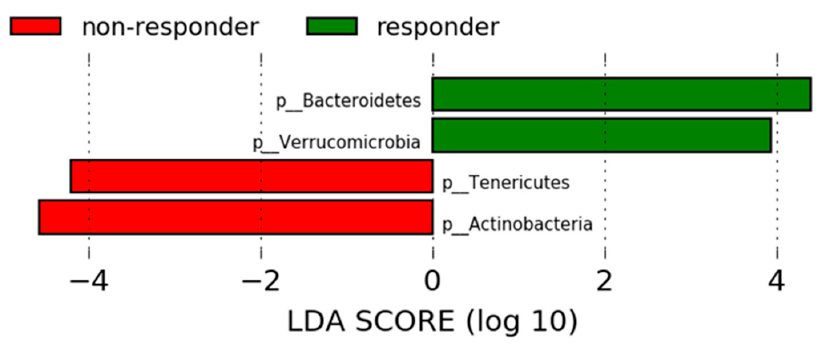
LefSe analysis to detect the enriched bacteria at phylum level between responder and non- responder subjects.